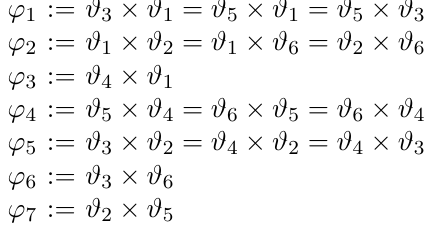
Fig. 8. area: πr 2